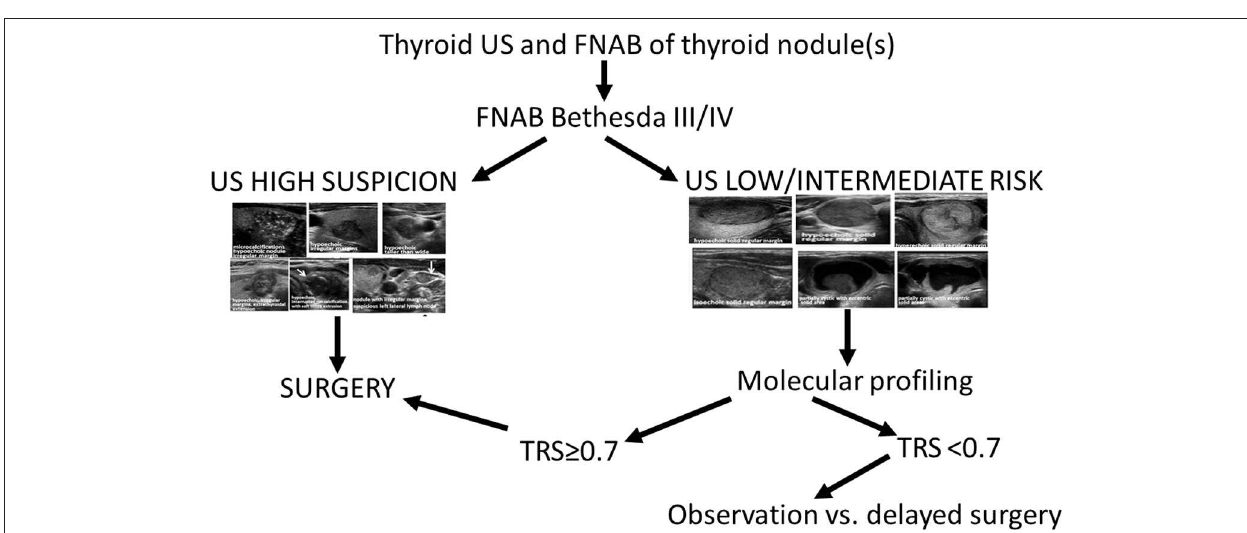
FIGURE 5 | Proposed algorithm for diagnosis and management of cytologically indeterminate nodules.